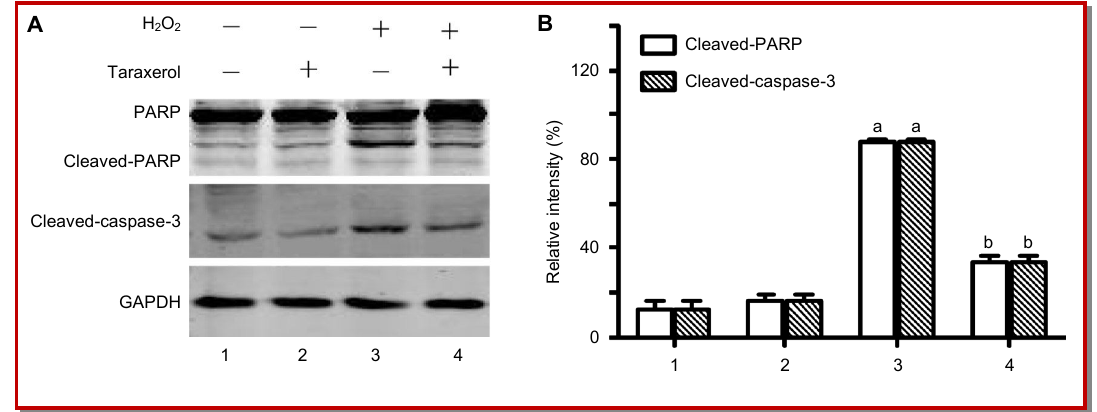
Figure 4: Taraxerol attenuates H 2 O 2 -induced reduction in cleaved-caspase-3 and cleavage of PARP. L02 cells were pretreated with or without 40 μ M taraxerol for 1 hour, followed by 0.4 mM H 2 O 2 treatment for 12 hours. A) Then, the expression of cleaved- caspase-3 and PARP was tested by Western blot. GAPDH was used to confirm that equal cell equivalents were loaded. B) Relative intensity of cleaved-caspase-3 and cleaved-PARP in Figure 4A. Data are expressed as mean ± SD (n = 3); a p<0.01 compared with control; b p<0.01 compared with the group of H 2 O 2 -treated L02 cells